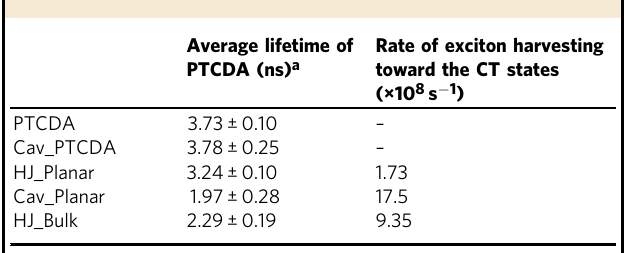
Table 1 The lifetime of PTCDA and the rate of exciton harvesting toward the heterojunction interface in and outside cavities.